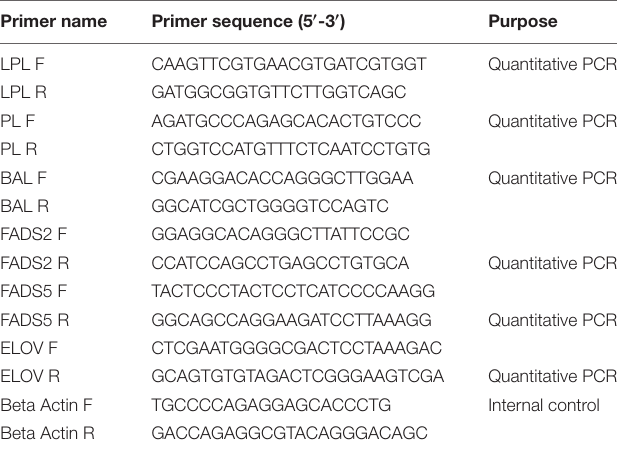
TABLE 4 | Primers used for the qRT-PCR analysis of lipolytic and long-chain fatty acid biosynthesis related